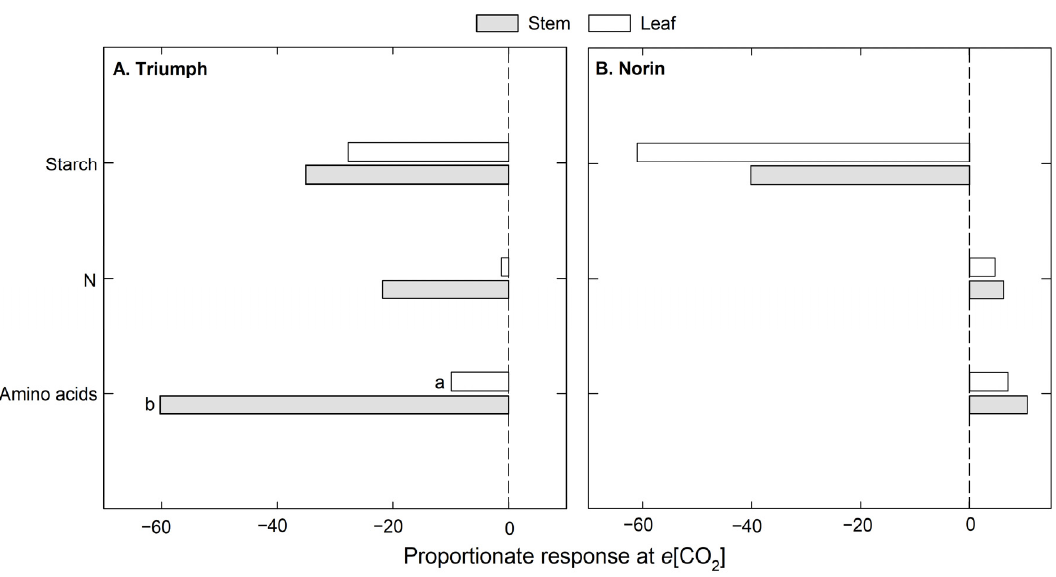
Figure 3. Percentage (%) of change under e [CO 2 ] with respect to a [CO 2 ] in two organs evaluated (stems and leaves) at the elongation stage in both wheat cultivars: ( A ) Triumph and ( B ) Norin. The letters indicate significant differences between organs ( p < 0.05).